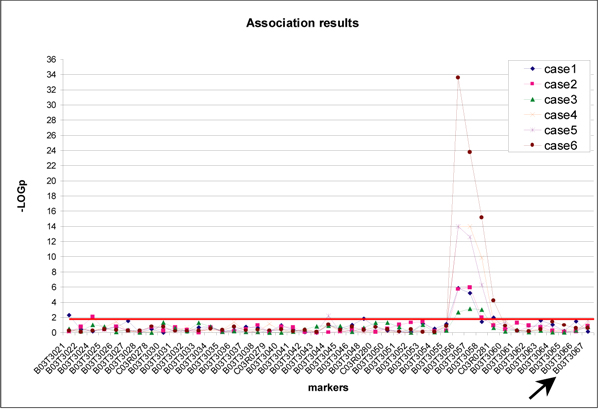
p-Values obtained from chi-square tests for independence, plotted as -log10(p-value). Value equivalent to p = 0.001 is indicated by bold red line. Case 1–6 reflects study populations selected as defined in the text. Case 1–3: 50 cases, 100 controls; Case 4: 250 cases, 500 controls; Case 5: 250 cases (original affection), 500 controls; Case 6: 250 cases (cases selected by MERLIN select function), 500 controls. Black arrow indicates marker documented to be linked to the disease locus.